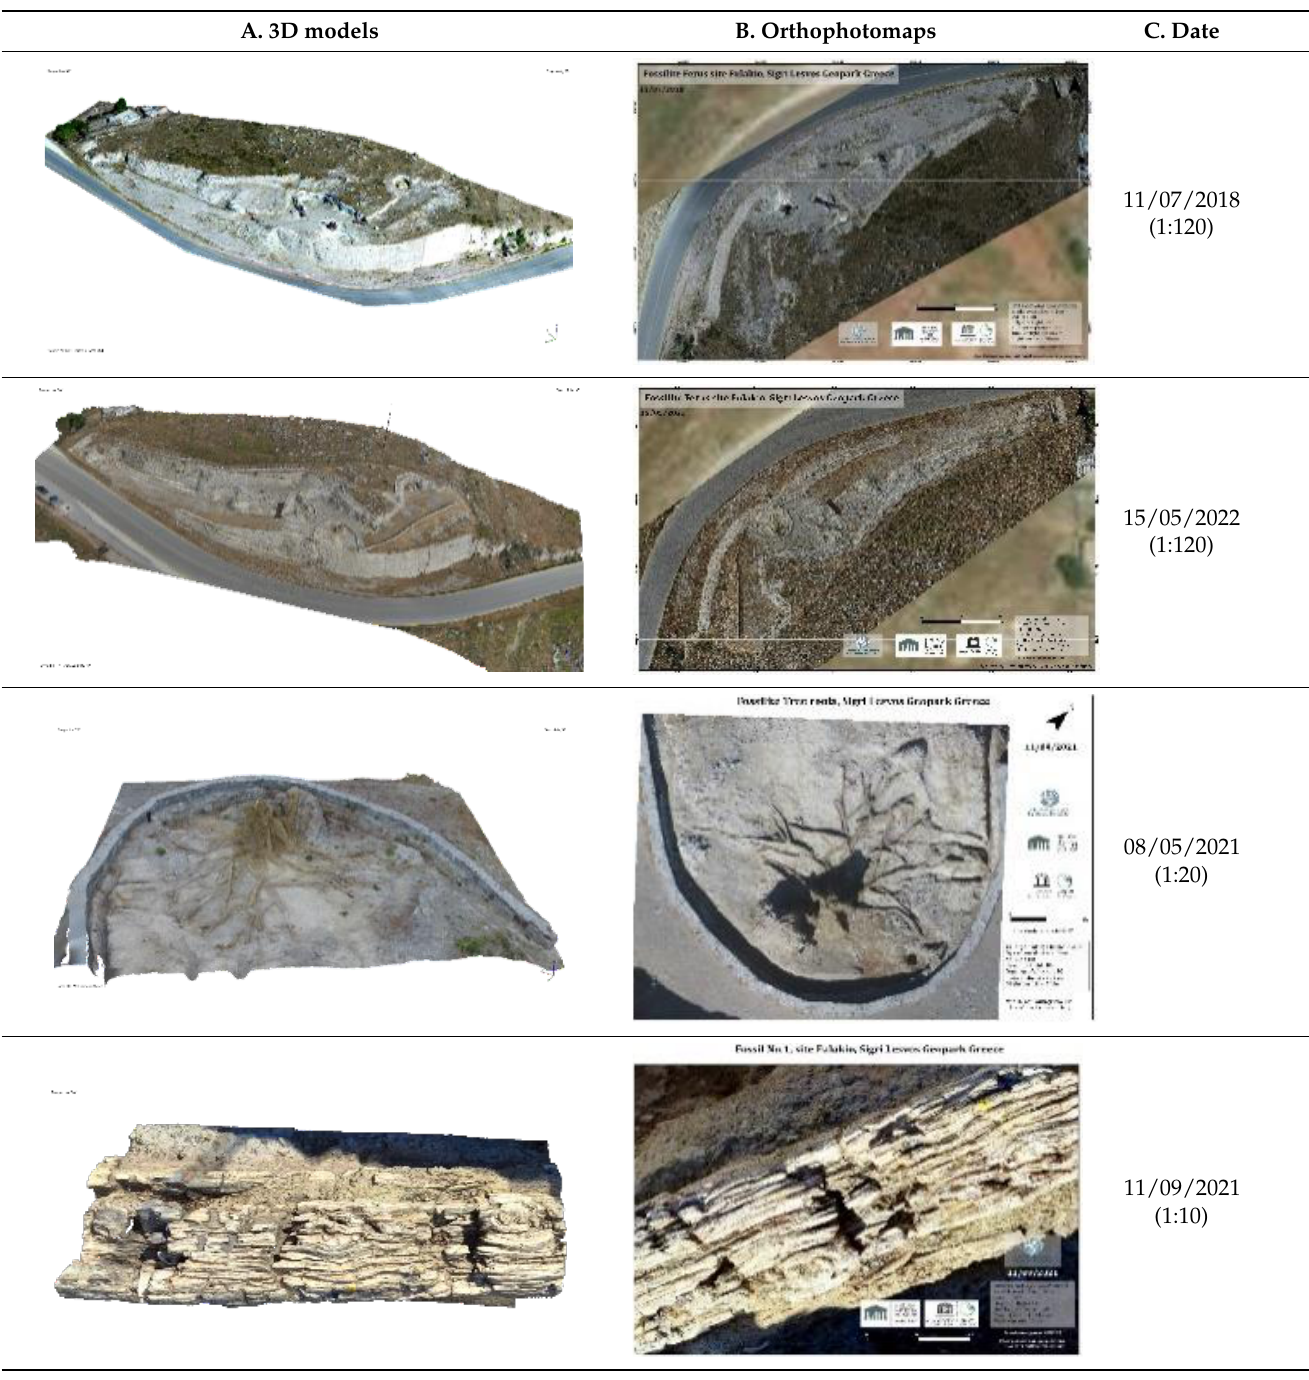
Table 4. Indicative results of image-based 3D modeling processing: (A) 3D models, (B) orthophoto maps, and (C) recording dates.